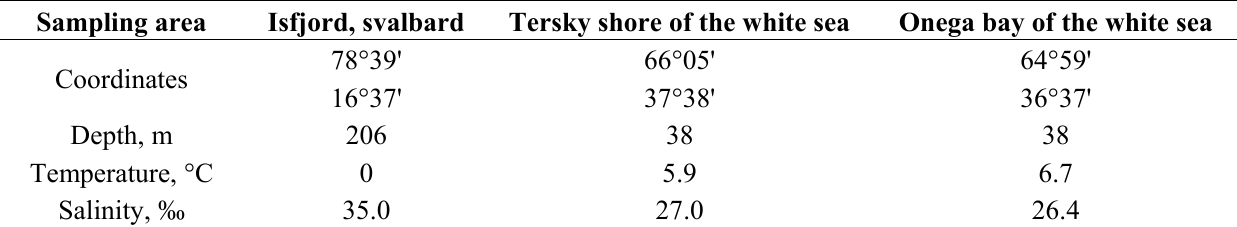
Table 3. Some characteristics of the sampling